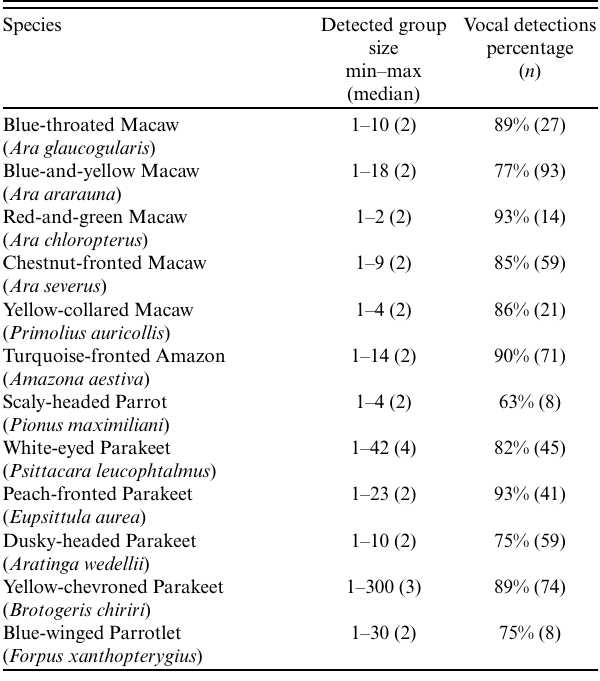
Table 2 . Group size and percentage of vocal detections for 12 parrot species in Beni savannas, northern Bolivia.